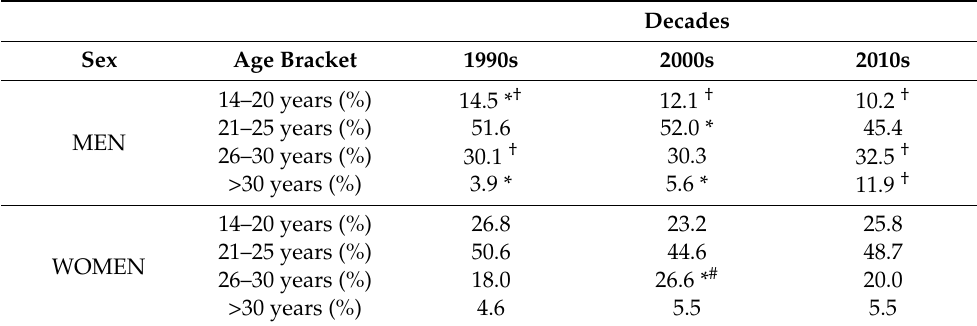
Table 1. Frequency distribution from the World Ranking top 100 (both men and women) according to age in the last few decades (1990s, 2000s and